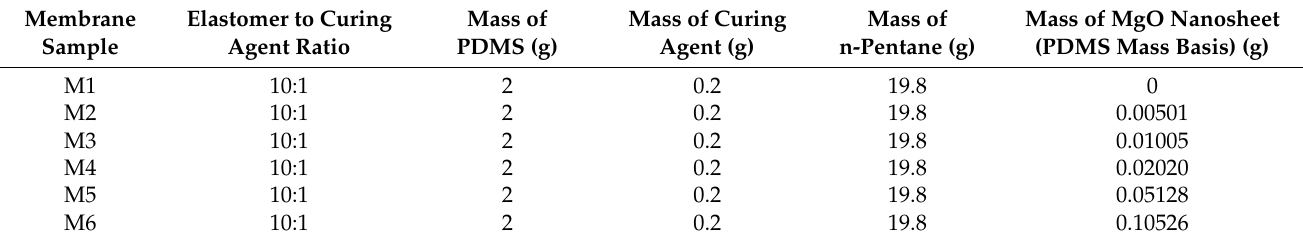
Figure 1. Schematic representation of membrane preparation. Table 1. Mass composition of the prepared membrane.